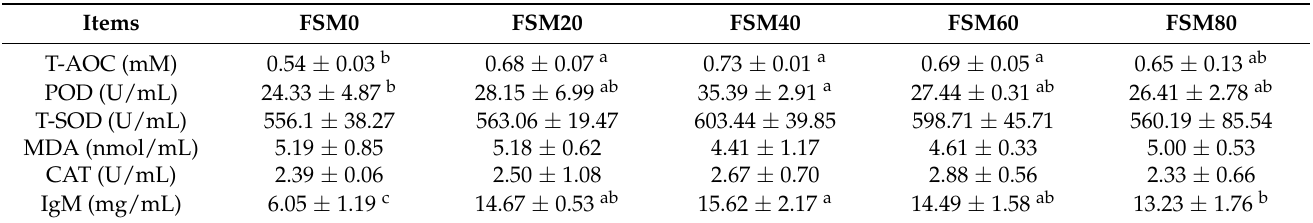
Table 2. Effects of fermented soybean meal instead of fish meal on serum antioxidant indices of crucian carp. T-AOC, total antioxidant capacity; POD, peroxidase; T-SOD, total superoxide dismutase; MDA, malondialdehyde; CAT, catalase; IgM, immunoglobulin M. The data are expressed as mean ± standard deviation. Different lowercase letters in the upper right of the data indicate that there was a significant difference between the two groups ( p <